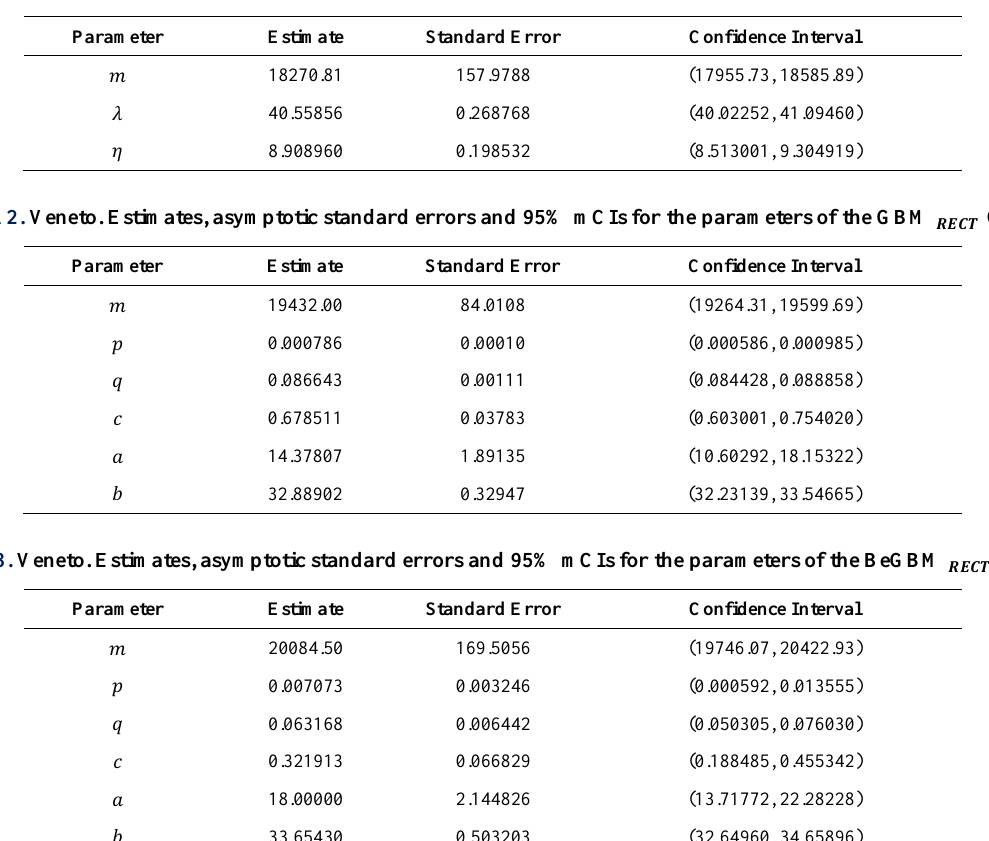
Table A1. Veneto. Estimates, asymptotic standard errors and 95% mCIs for the parameters of the LOG model (2).